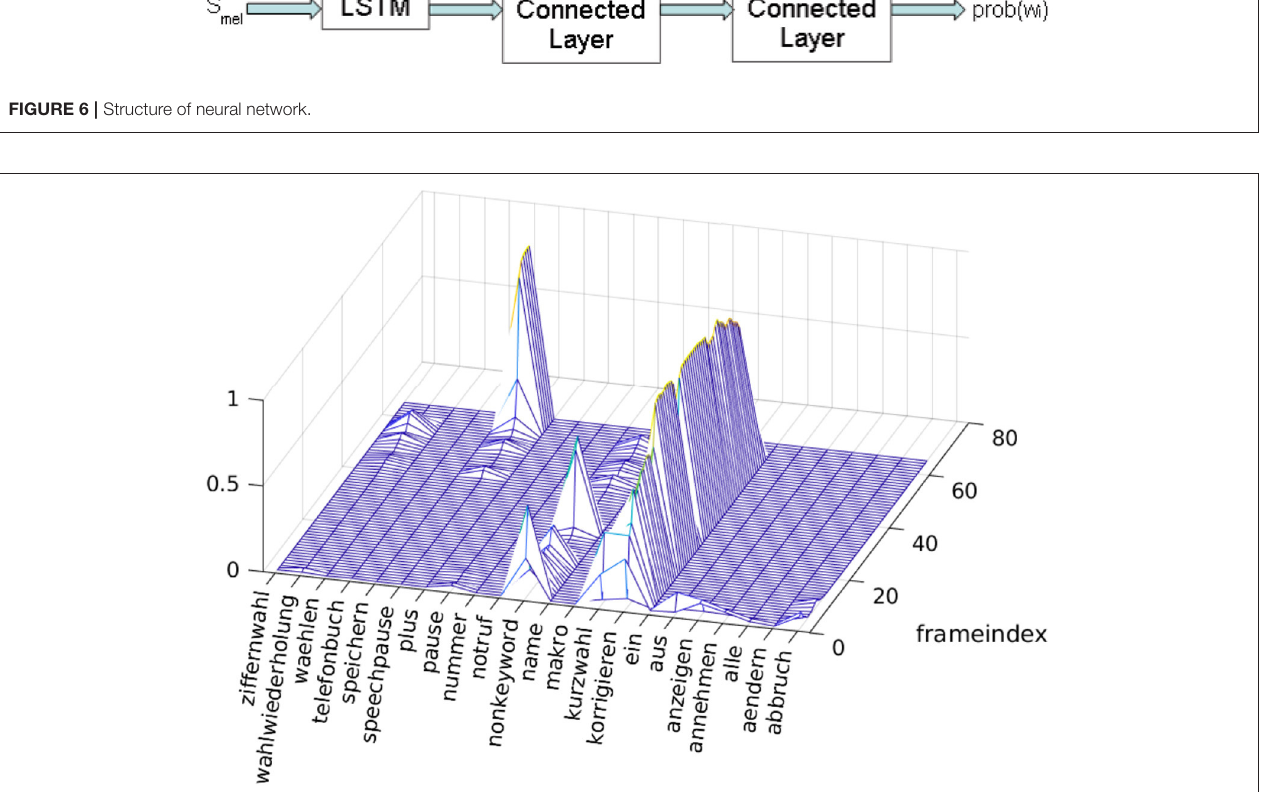
FIGURE 7 | Twenty-two output values of the neural network for the spoken word